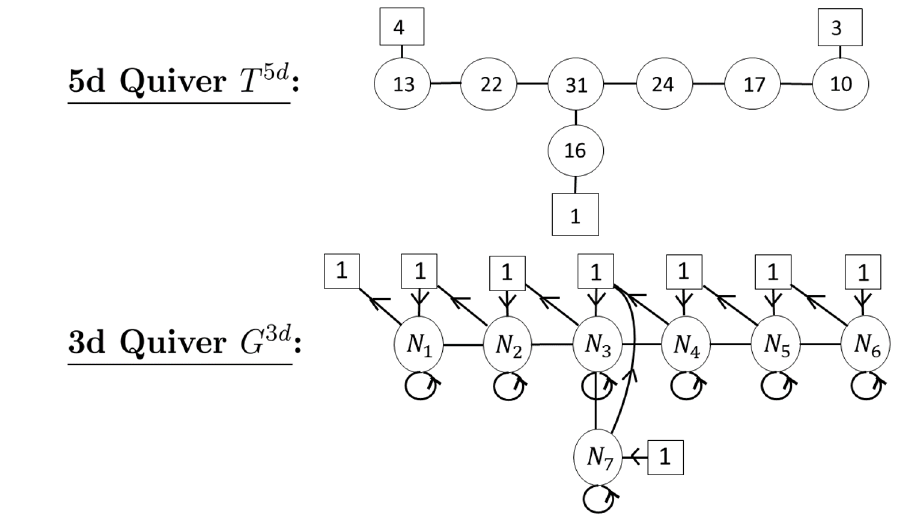
Figure 5. Sphere with 3 full E 7 punctures: 5d theory T 5d and 3d theory G 3d resulting from W S .